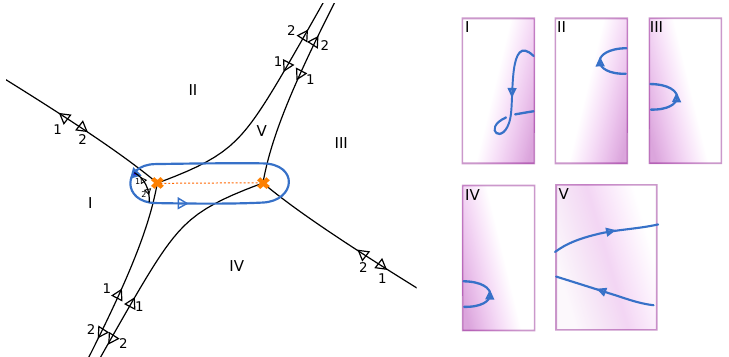
Figure 28 . An unknot K encircling two strands of the branch locus of the covering f M ! M . Left: the projection of K to C . Right: the projections of K to (cid:12)ve pieces of the leaf space. (For simplicity, we do not show the leaf spaces glued together.)